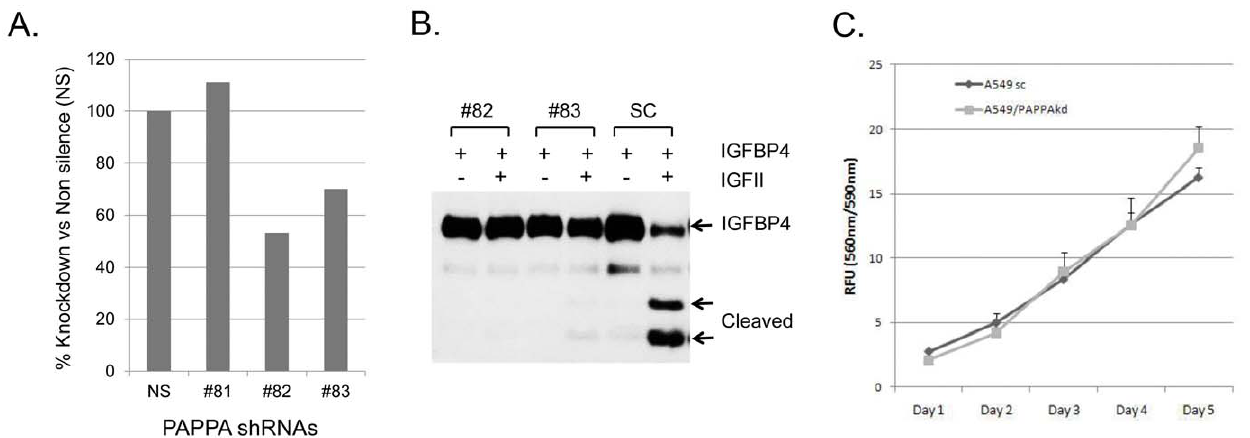
Figure 2. PAPPA knockdown in A549 cells lines. A549 cells were transduced with lentiviral particles containing shRNAmir ( # 81 # 82 and # 83) to PAPPA and non-silencing shRNAmir (SC) and selected with puromycin. (A) PAPPA mRNA levels from these cell lines determined by real-time PCR quantification and depicted as relative level to non-silencing control. (B) IGF dependent protease activity in conditioned medium from PAPPA knockdown A549 cells lines. (C) Growth curve of PAPPA knockdown A549 cells line # 82 and non-silencing control line.